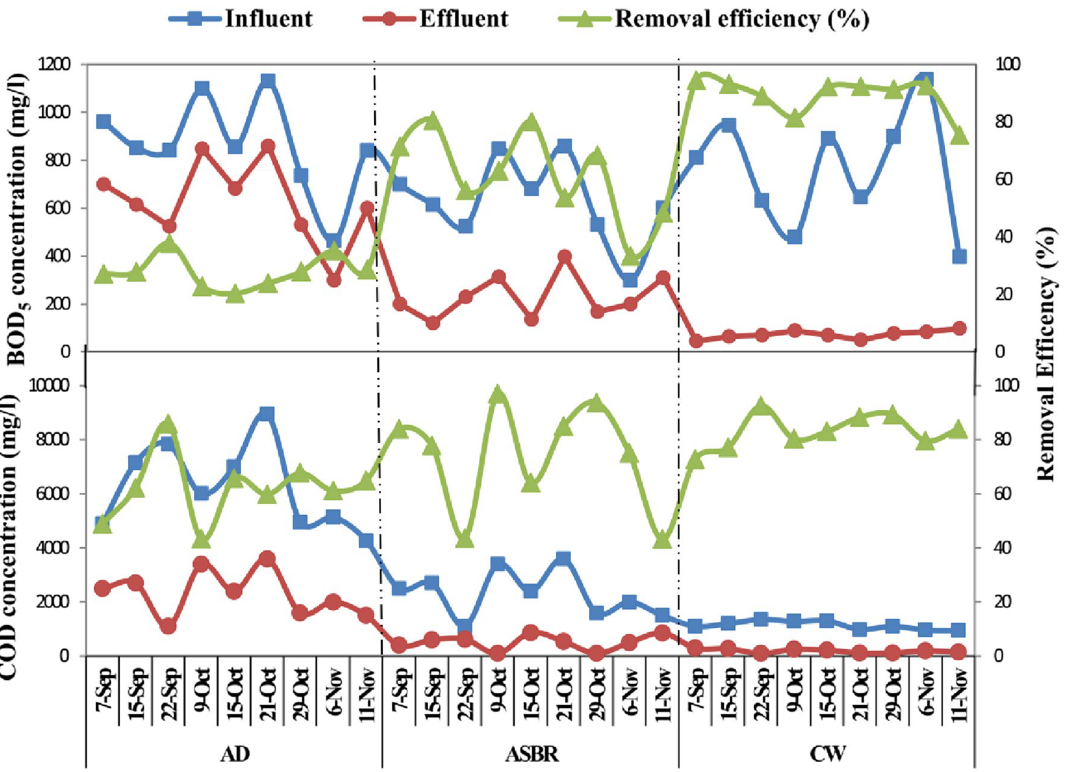
Fig. 5 Variations in removal efficiencies of BOD 5 and COD with different concentration in the influent and effluent of each unit operation during the sampling